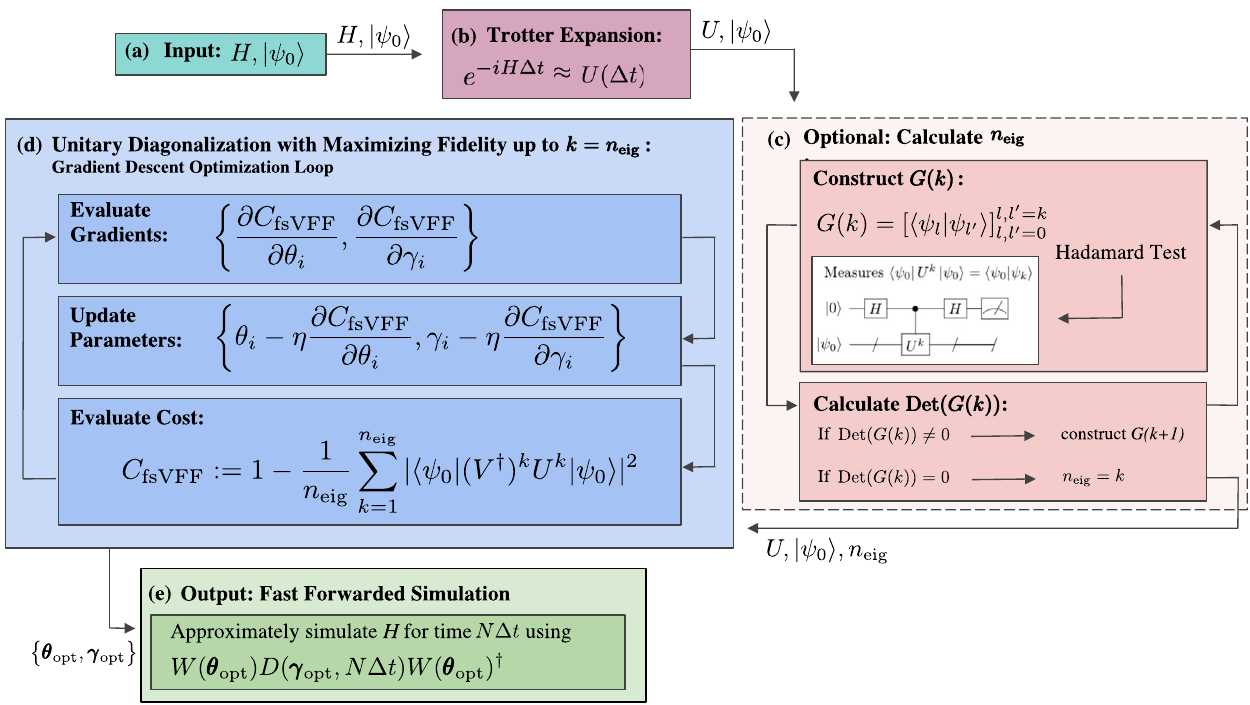
Fig. 1 The fsVFF Algorithm. a An input Hamiltonian and an initial input state are necessary ( b ) to create a single time-step Trotterized unitary, U ( Δ t ) and ( c ) to calculate the number of eigenstates that have non-zero overlap with the initial state. The value of n eig can be calculated by constructing a matrix of state overlaps U k ψ 0 j i and increasing the matrix dimension until the determinant is zero. d The unitary is then variationally diagonalized into the form, V ( α , Δ t ) = W ( θ ) D ( γ , Δ t ) W † ( θ ). The cost function C fsVFF is minimized with a classical optimizer (e.g., gradient descent), where the parameters θ and γ are updated. e The optimal parameters θ opt and γ opt are then used to implement a fast- forwarded simulation with the diagonalized unitary